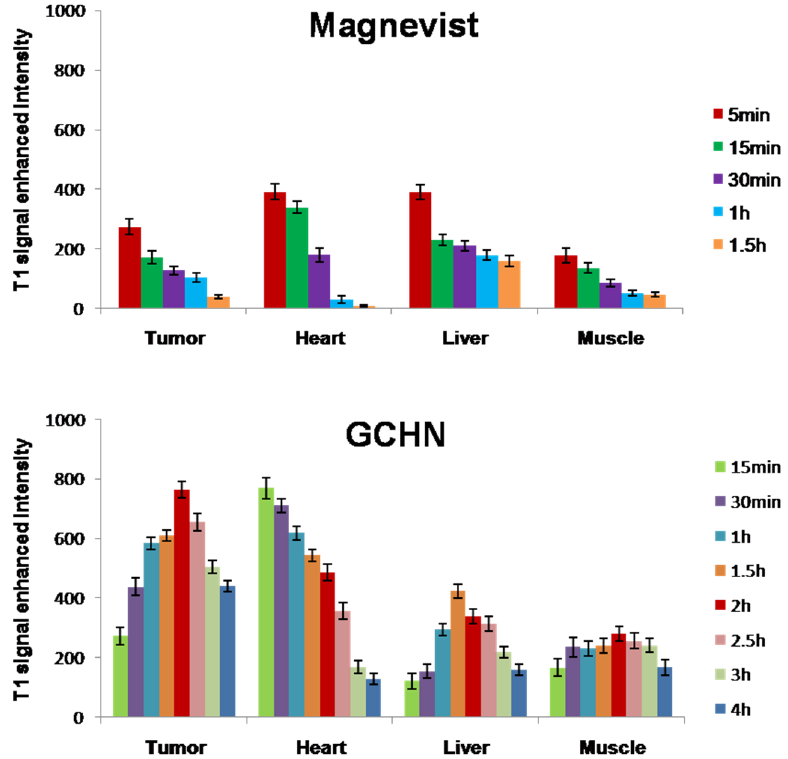
Figure 8. The results of the enhanced signal intensity in different tissue in vivo .